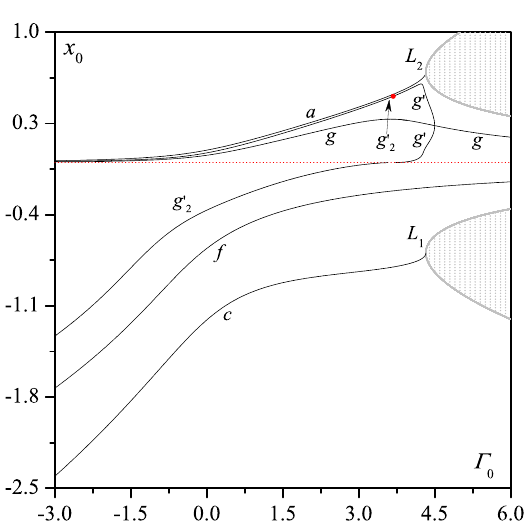
Figure 1. The basic families of planar periodic orbits of the Hill problem as they were determined in [23]—reproduction here. Forbidden regions to motion are shown with light grey color while red dashed line represents the position of the smaller primary body. The respective families have been recomputed here in order their VSR orbits to be